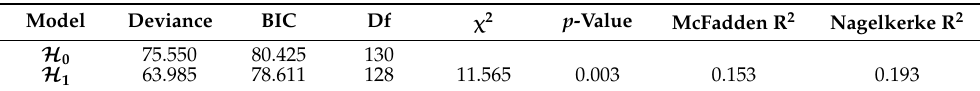
Table 14. Summary of the logistic model characterizing the relationship between the variable Y 3 “Have you been hospitalized?”and the variables X 2 and Z 2 (Model 6).